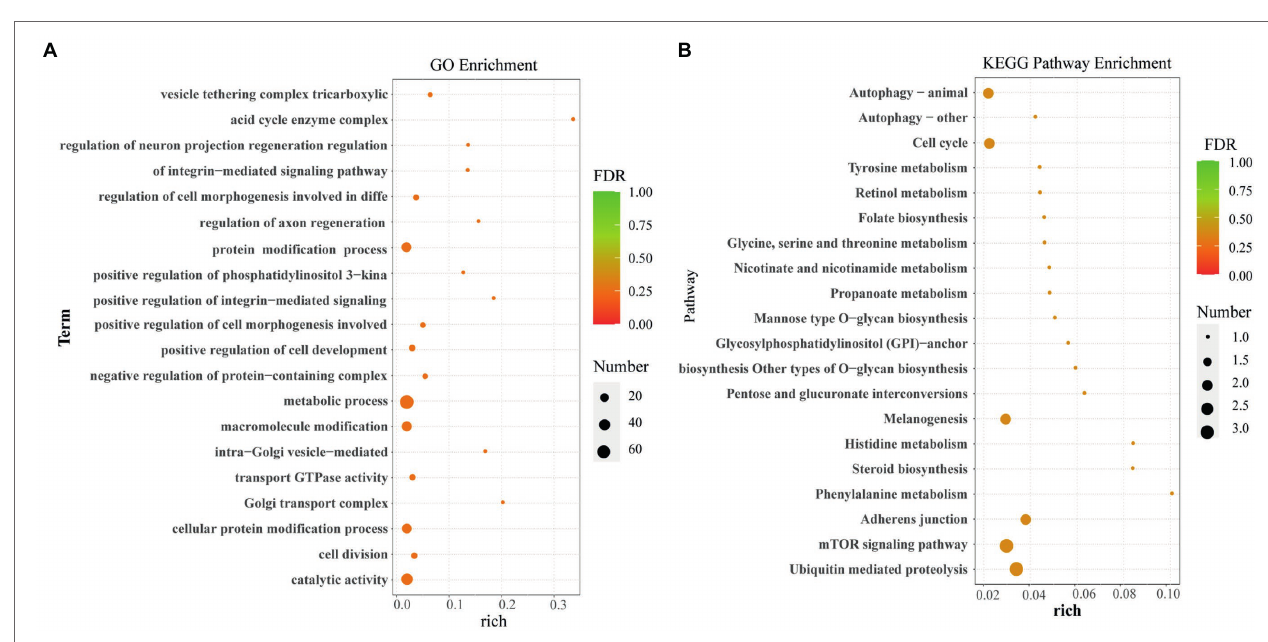
FIGURE 4 | Functional enrichment analysis. (A) The GO enrichment analysis for host genes of the differentially expressed circRNAs. (B) The KEGG pathway analysis for host genes of the differentially expressed